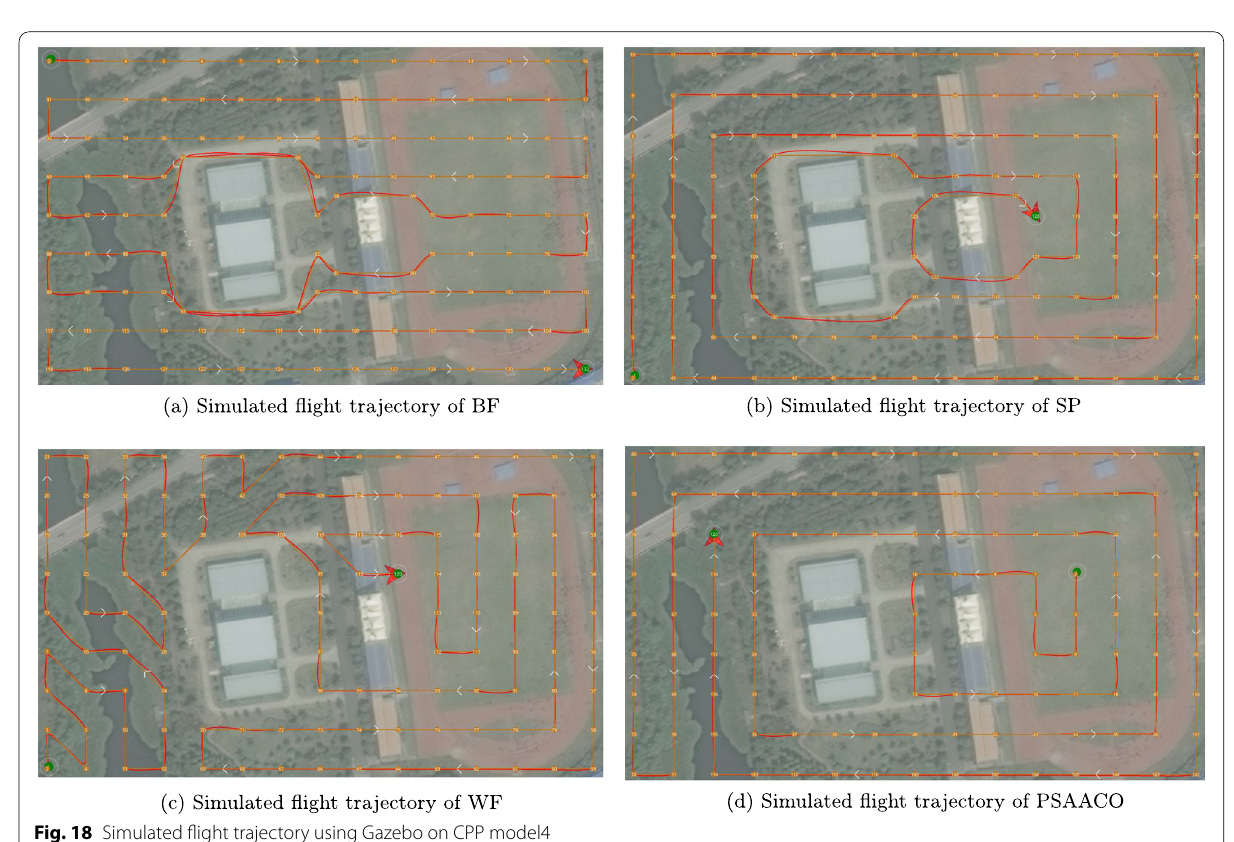
Fig. 18 Simulated flight trajectory using Gazebo on CPP model4